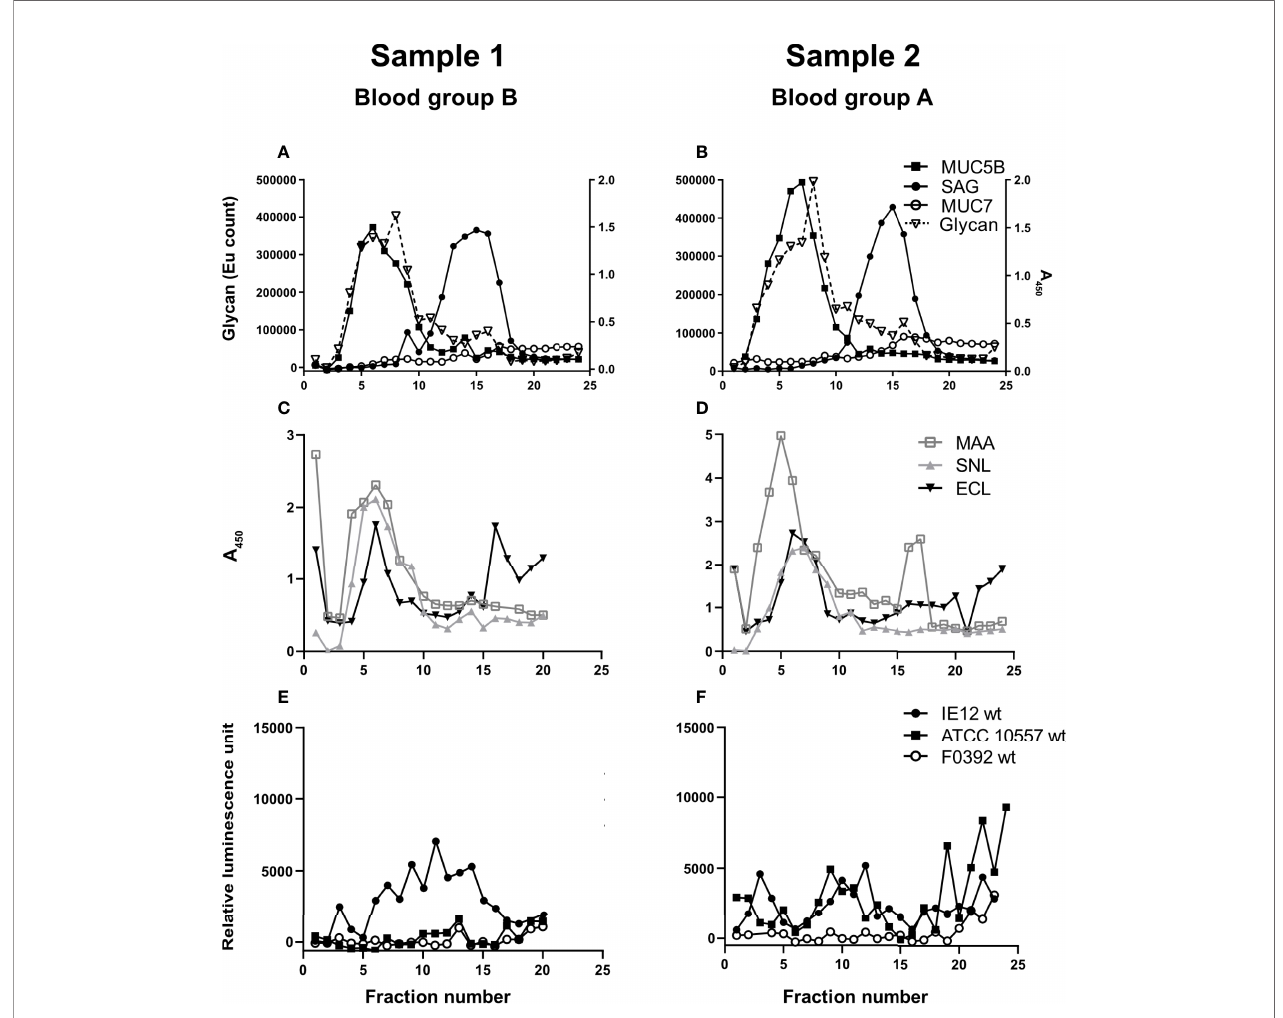
FIGURE 2 | Insoluble salivary mucins and their binding to lectins and S. oralis . Fractions from CsCl density gradient centrifugation of the insoluble saliva fractions (solubilized by reduction) were collected from the bottom of the tube, diluted 1:20 and analyzed for: (A, B) carbohydrate, MUC5B, MUC7 and SAG. (C, D) Fractions were probed with the lectins SNA-I for a 2,6-linked sialic acid, MAA for a 2,3-linked sialic acid and ECL for Gal b 1-related oligosaccharides. To visualize the MAA and ECL signals in the graphs, their signals were multiplied by 10. (E, F) Fractions were assessed for S. oralis IE12 WT, ATCC 10557 WT and F0392 WT